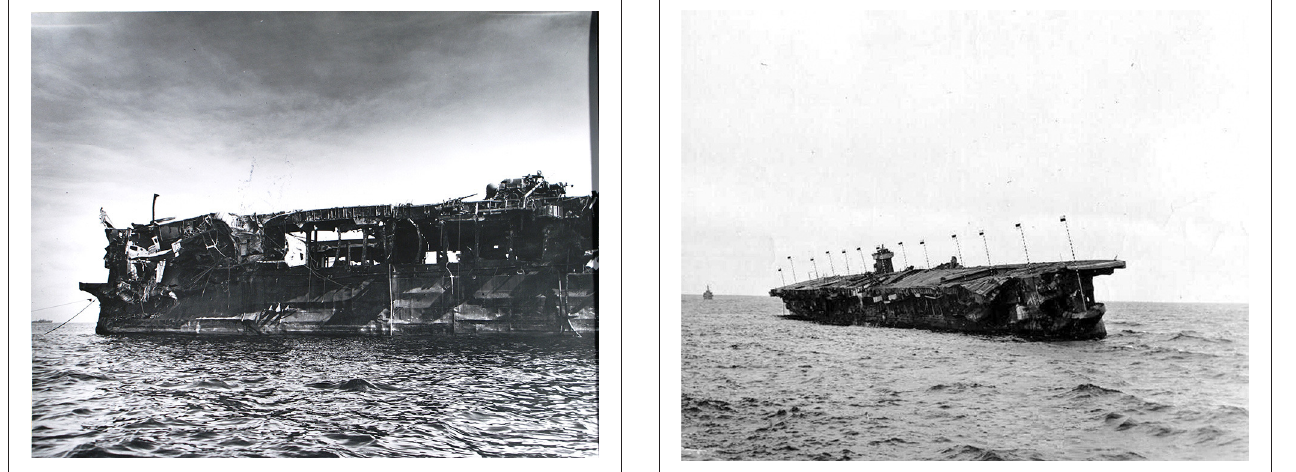
FIGURE 6 | Independence sinking (U.S. National